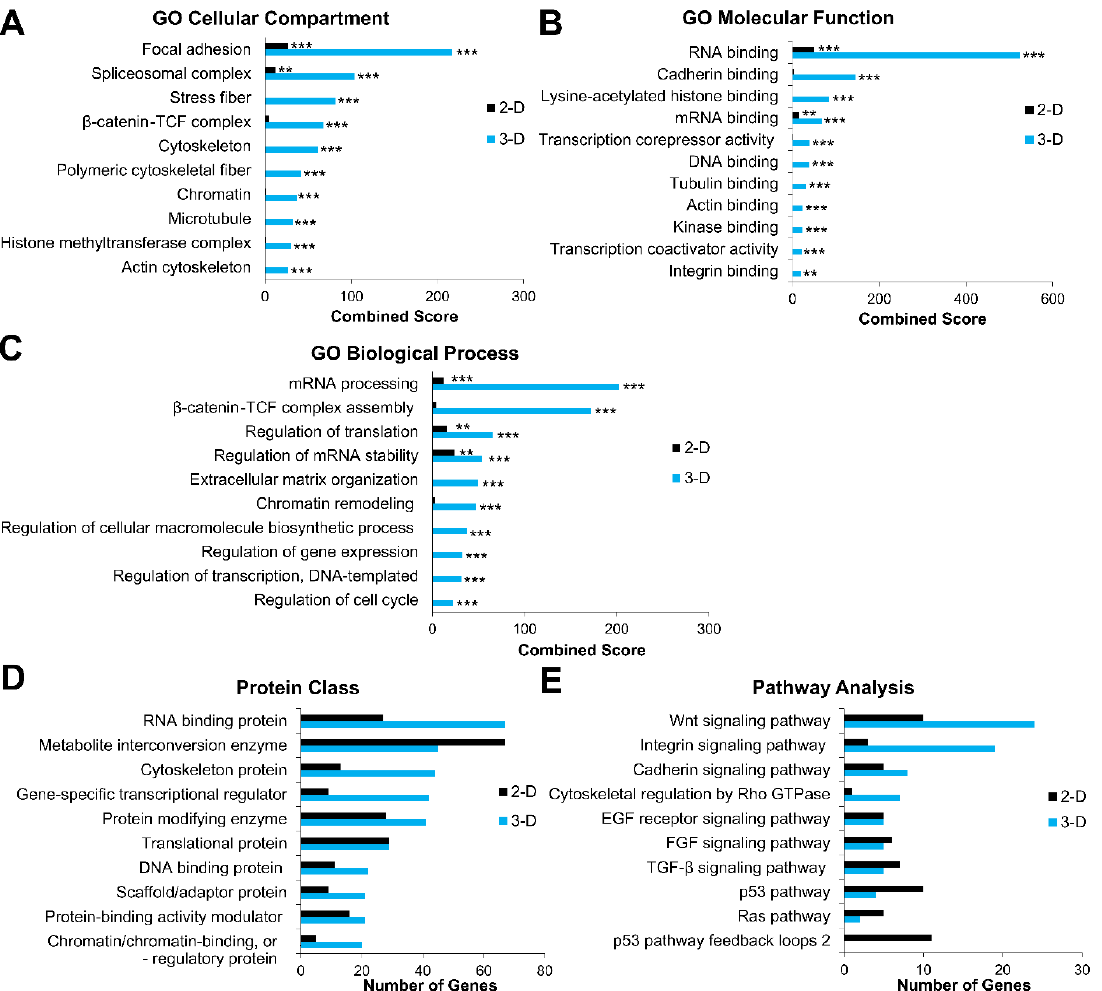
Figure 5. Gene ontology analysis of differentially expressed genes in naïve ESCs cultured under 2-D and 3-D conditions. ( A – C ) Enrichr and ( D , E ) protein analysis through evolutionary relationships (PANTHER) analysis of differential gene expression with Benjamini – Hochberg false discovery rate (FDR) < 0.05 as determined by DESeq2 analysis. ( A – C ) Gene ontology (GO) term enrichment analysis depicting upregulated differentially expressed genes (DEGs) associated with the cellular compartment, molecular function, and biological processes, respectively. The x -axis represents the combined score ( p -value multiplied by the z-score) generated by Enrichr (** p ≤ 0.01, and *** p ≤ 0.001). ( D , E ) Upregulated protein classes and pathways associated with 2-D in 3-D cultured Elf1 cells according to PANTHER analysis, respectively. The x -axis represents the number of genes associated with each category.